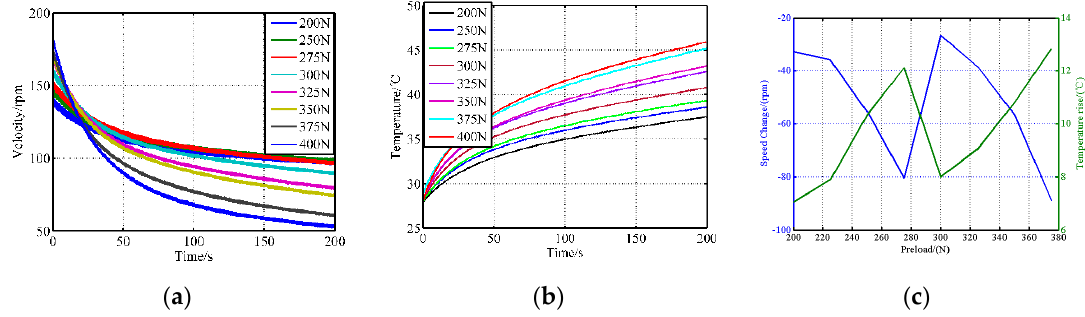
Figure 5. The startup-shutdown response under different pre-stressing forces (experimental): ( a ) the velocity response; ( b ) the temperature change; ( c ) temperature rise and speed decline.